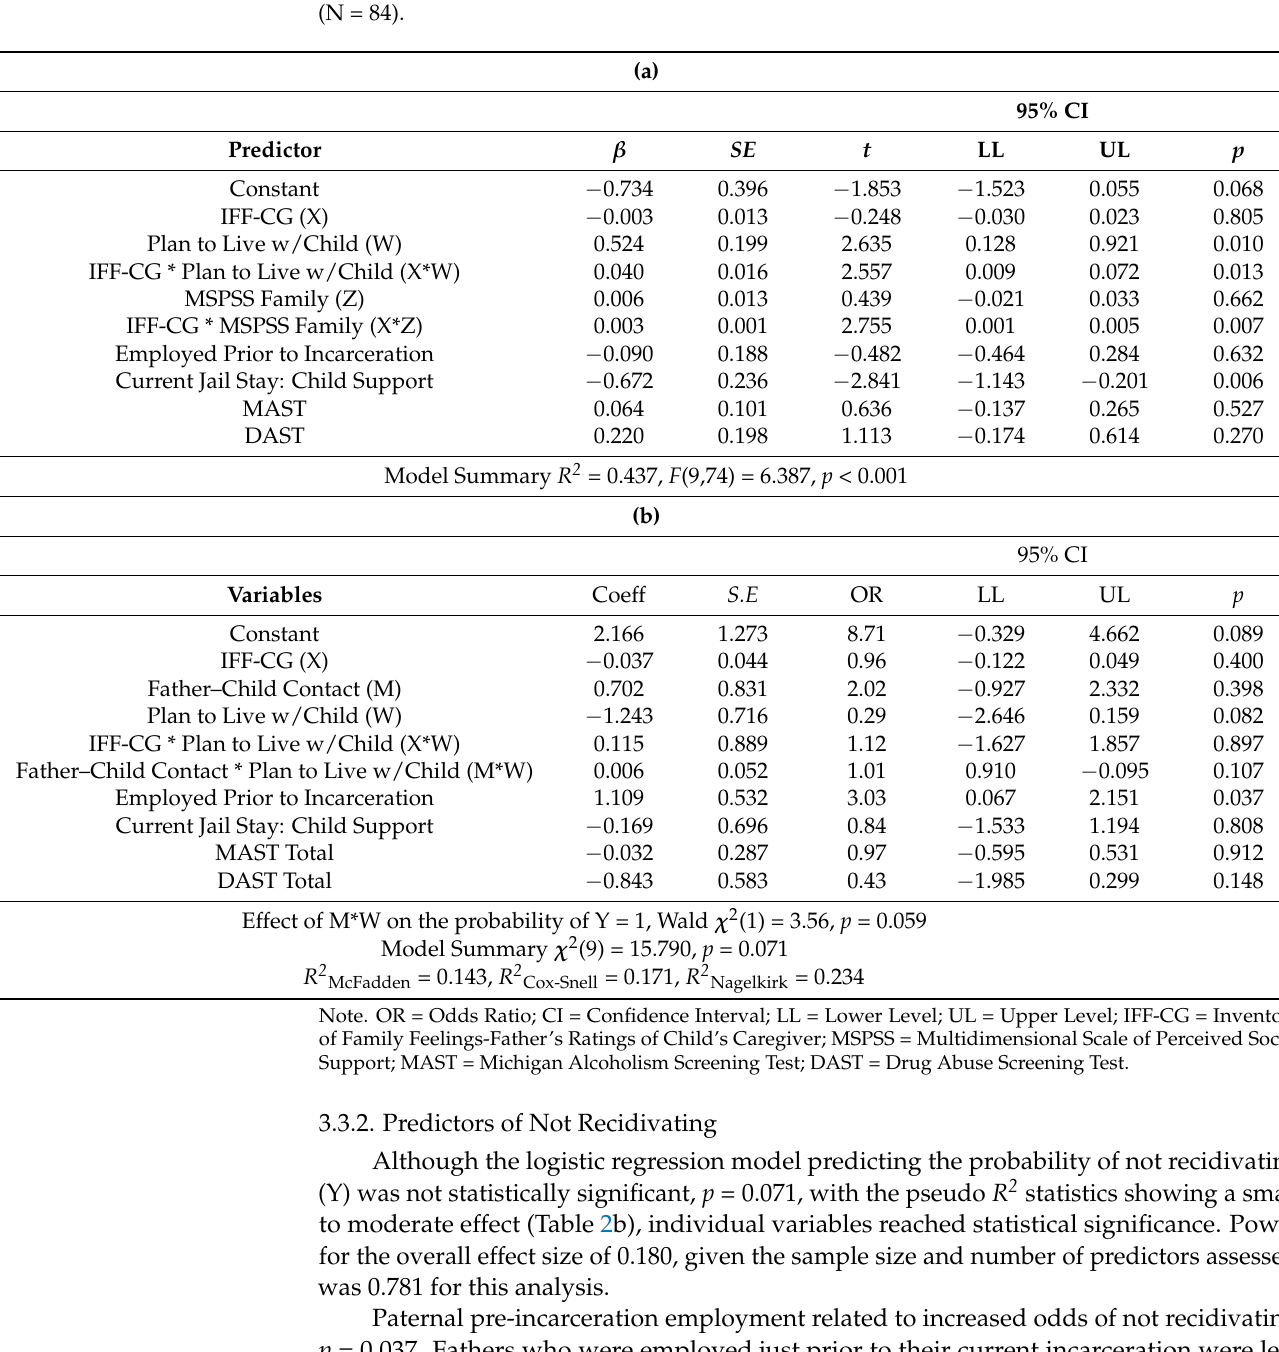
Table 2. ( a ). Predictors of Father–Child Contact Frequency During Incarceration: Multiple Regression (N = 84). ( b ). Predictors of Fathers Not Recidivating During the First Reentry Year: Logistic Regression (N =